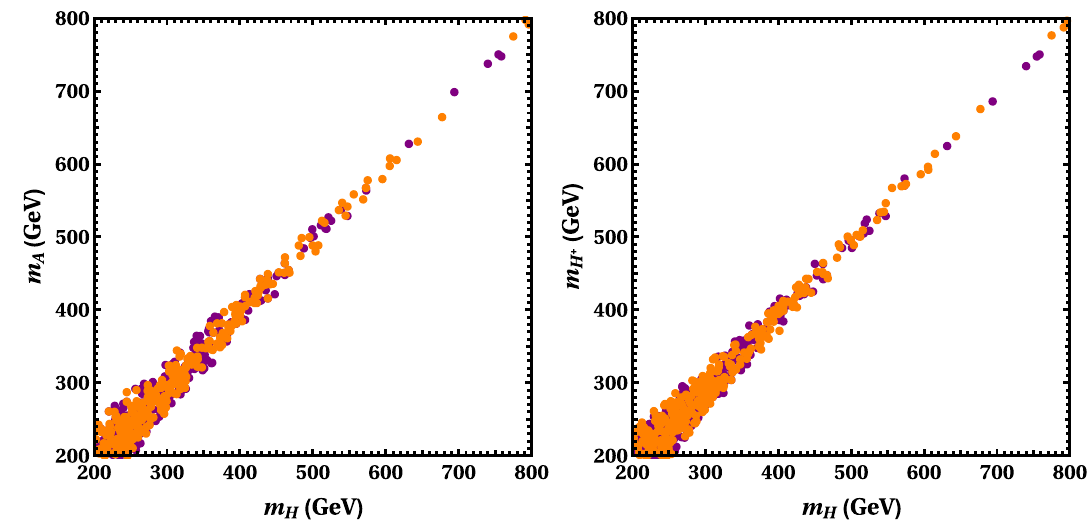
Fig. 4 Same figure as Fig. 3 but for Scenario-II